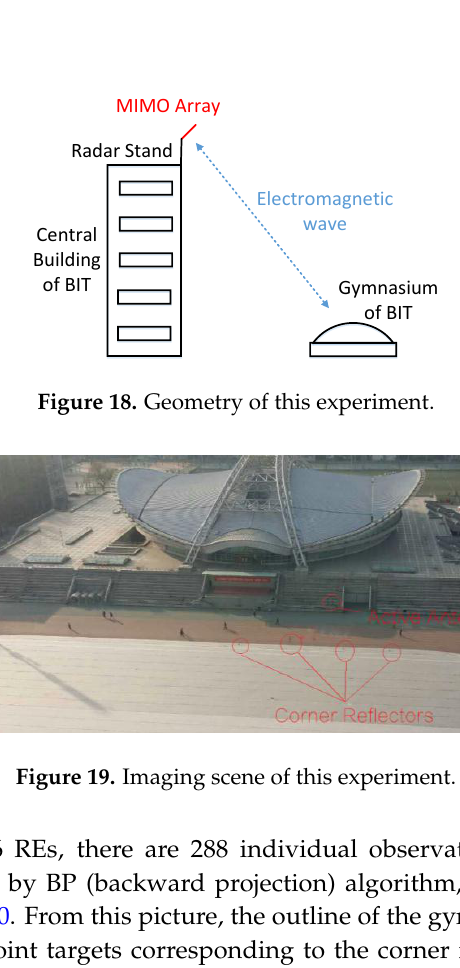
15 of 19 Table 2. Parameters of the Experimental MIMO Radar System. Parameters